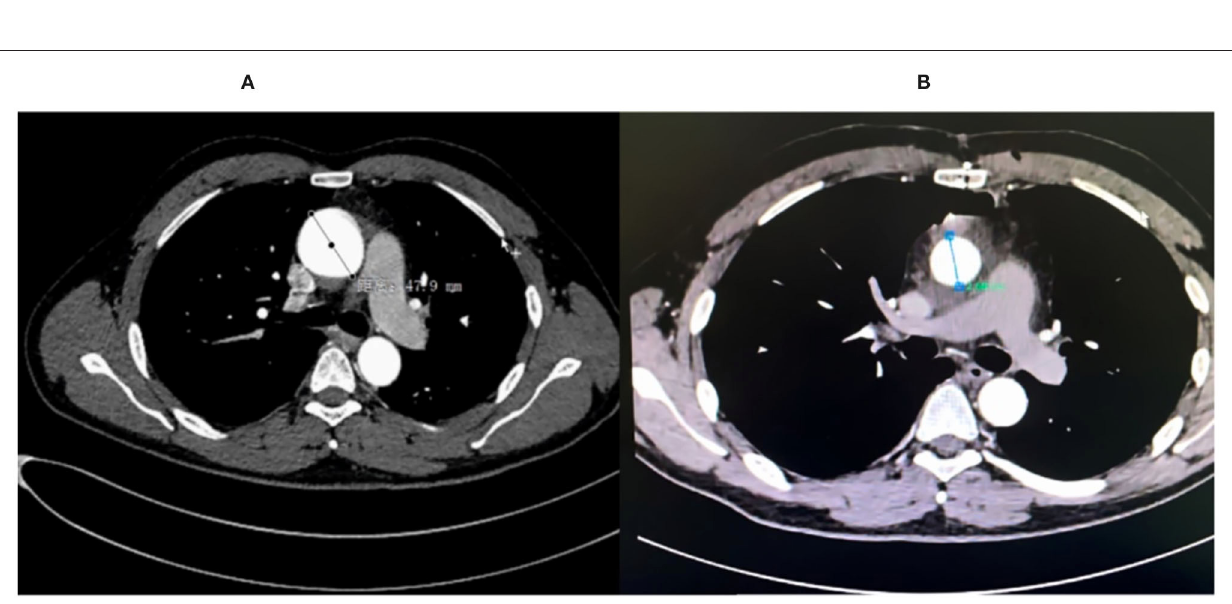
Frontiers in Cardiovascular Medicine |